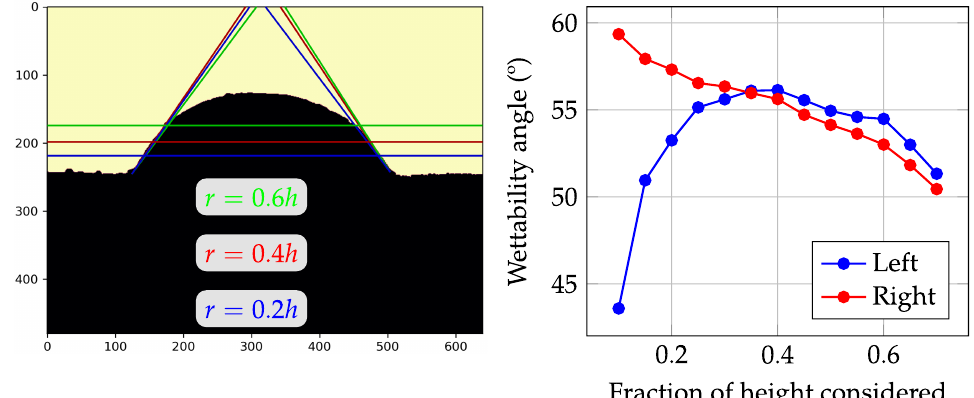
Figure 9. Influence of the height r considered when computing wettability angles (example shown pertains to track 1).